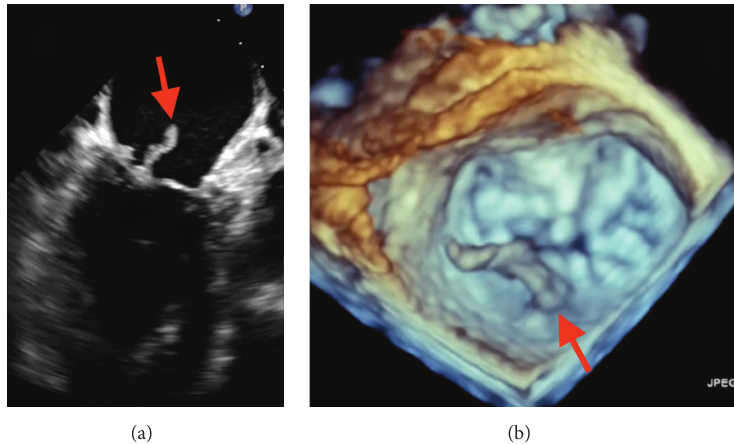
Figure 1: (a) shows the large vegetation on the P2 scallop of the posterior mitral valve on 2D TEE. (b) Corresponding mass noted on RT- 3DTEE.